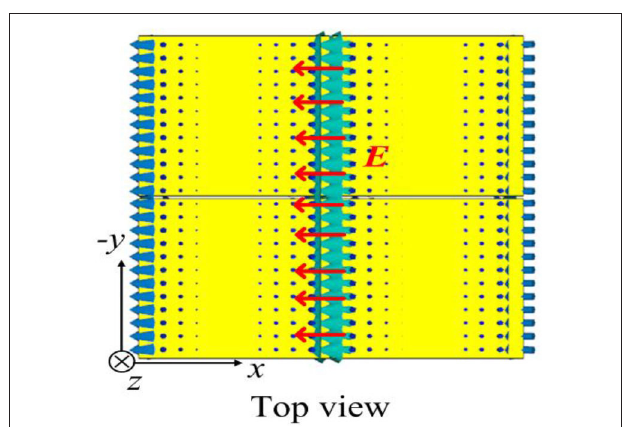
FIGURE 3 | The electric field distribution on the surface of HRIM.